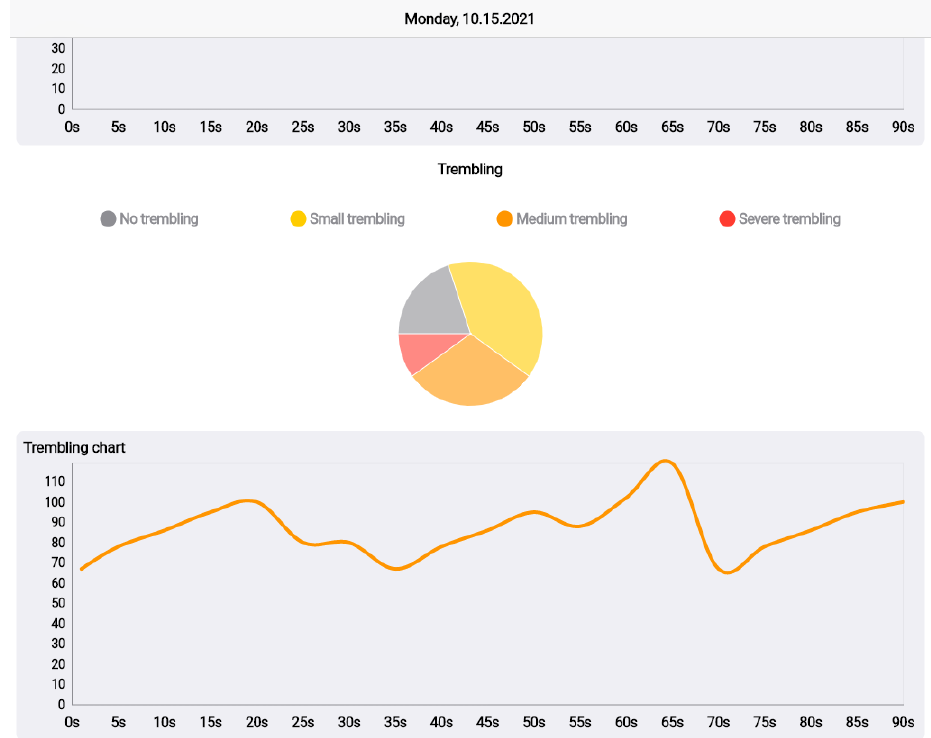
Figure 7. Trembling chart and diagram.